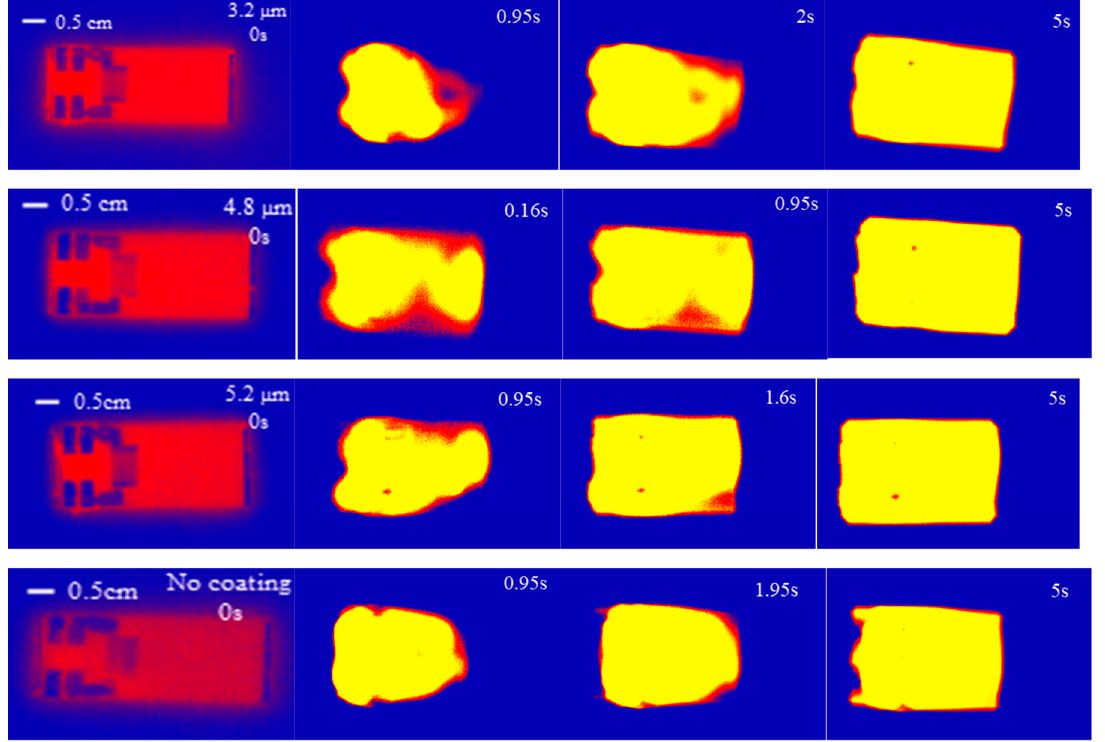
Figure 11. The thermal effect distribution of the device under different coating thicknesses.